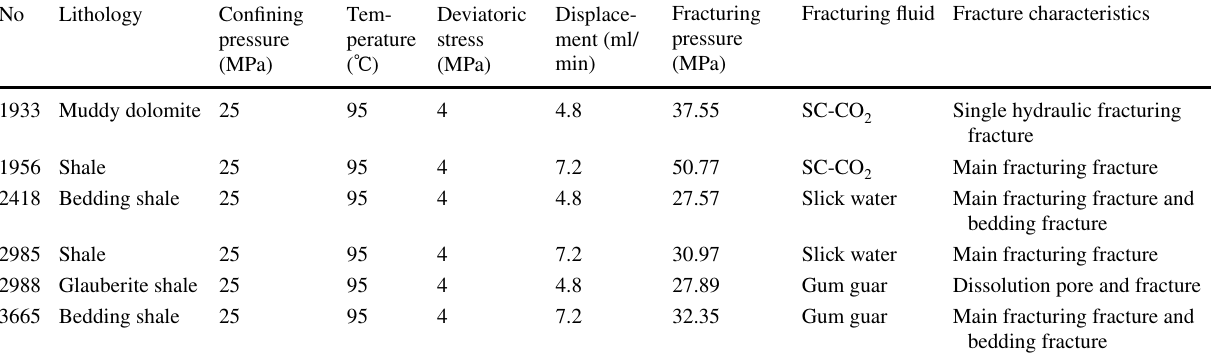
Main fracturing fracture—refers to the hydraulic fracturing fracture perpendicular to the bedding plane; bedding fracture—refers to the shale lamina opened during